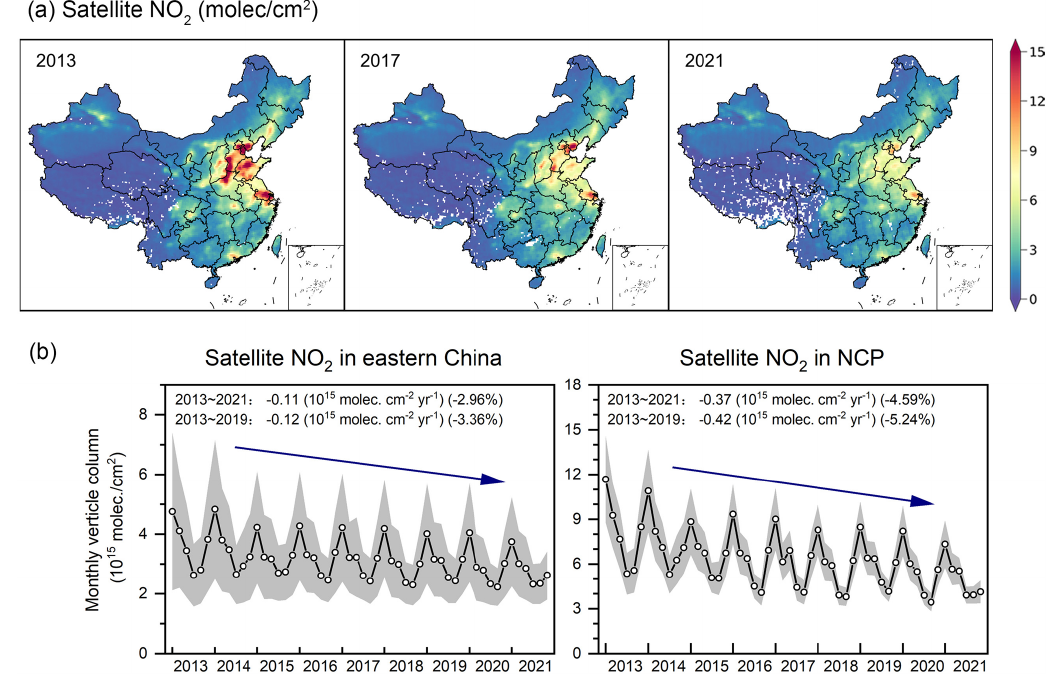
Figure 5. (a) Maps of average satellite-based NO 2 columns from April to September and (b) monthly mean NO 2 columns averaged over eastern China and the North China Plain in April–September. Gray shading: mean value ± 50% standard deviation across all grids for each month. Inset: absolute annual linear trend and percentage of annual trend (%yr − 1 , the linear trend divided by the 2013 mean values).